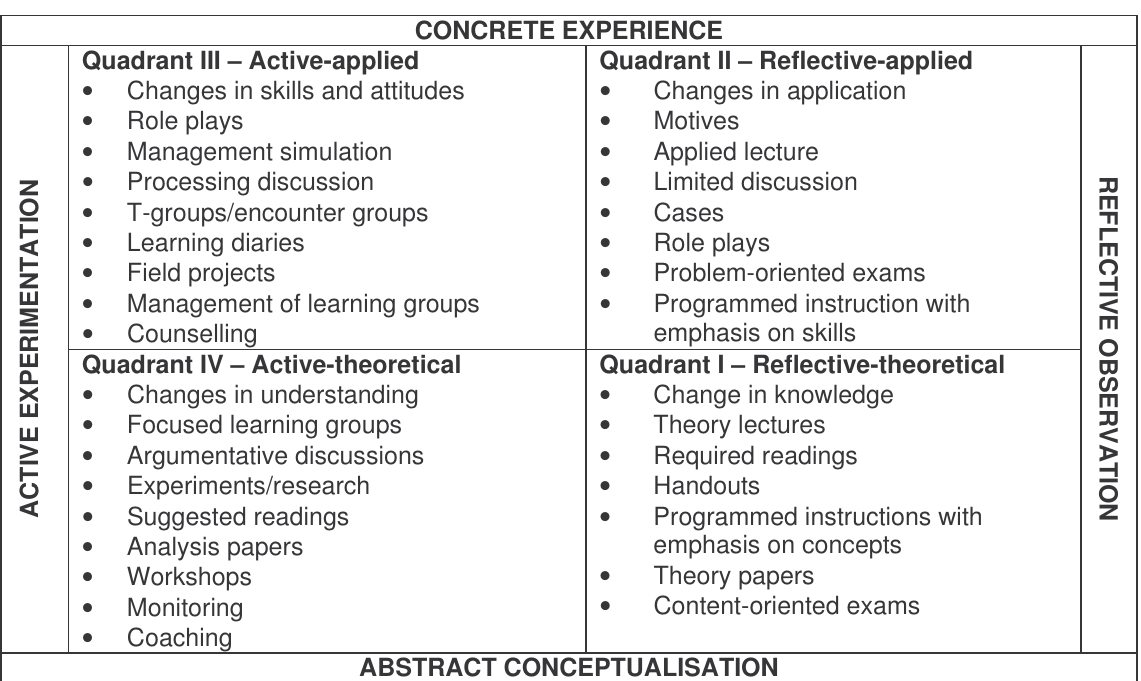
Table 1: Conceptual grid of learning styles and pedagogical